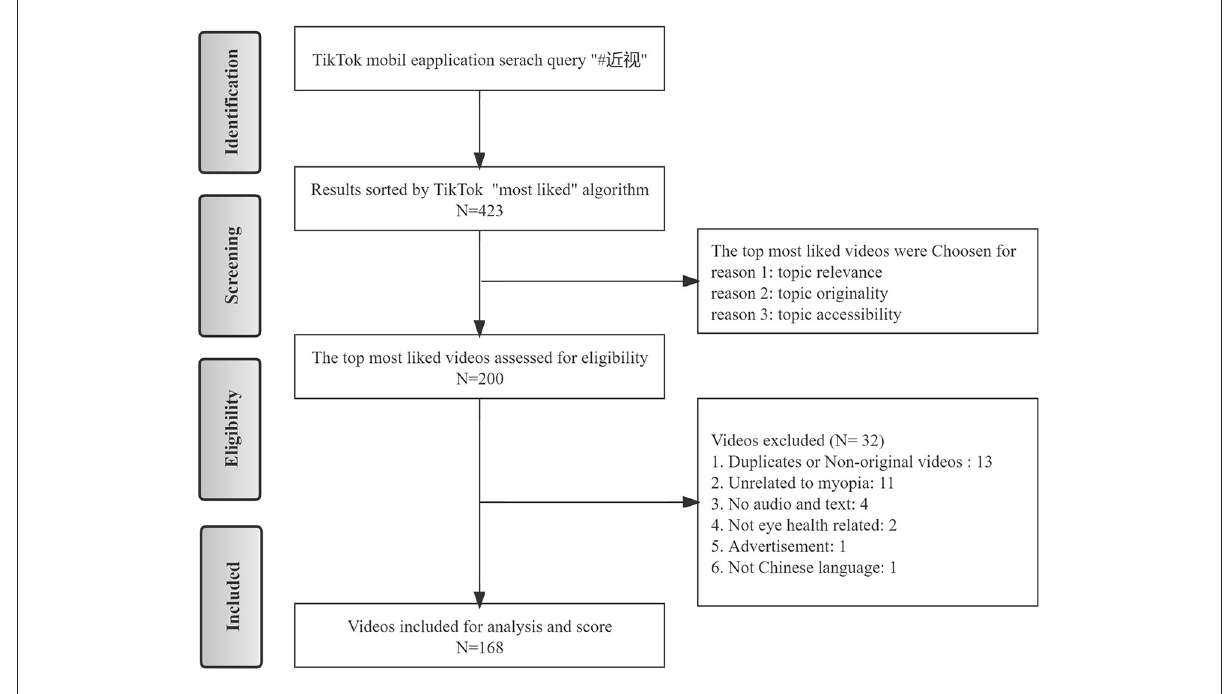
FIGURE1 The flow chart of the inclusion method of the retrived tiktok